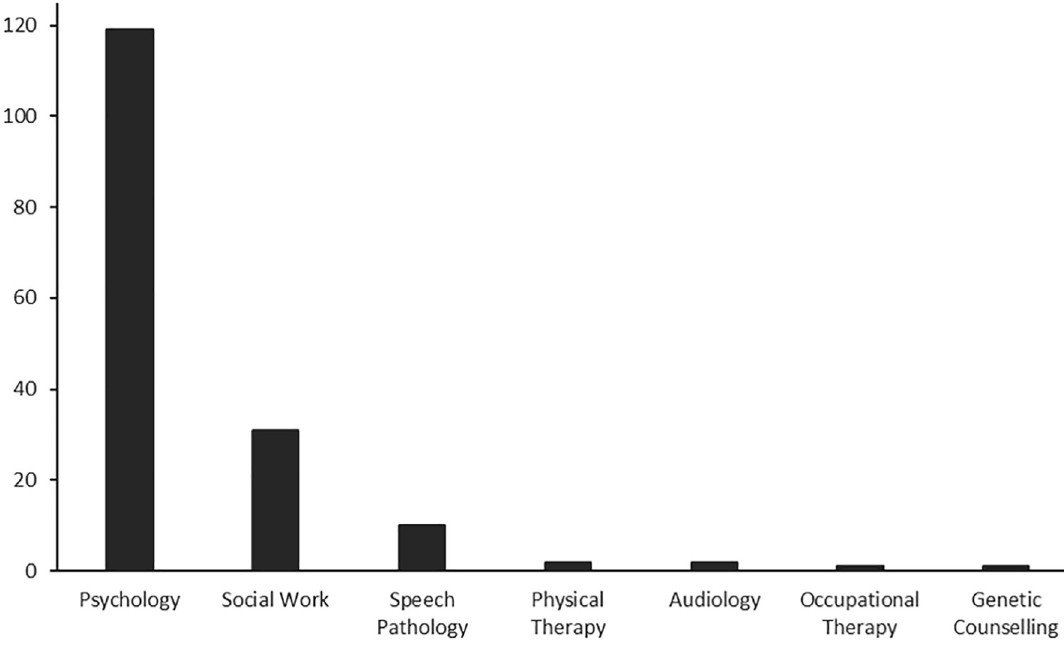
Fig 2. Number of studies that included participants from each of the allied health